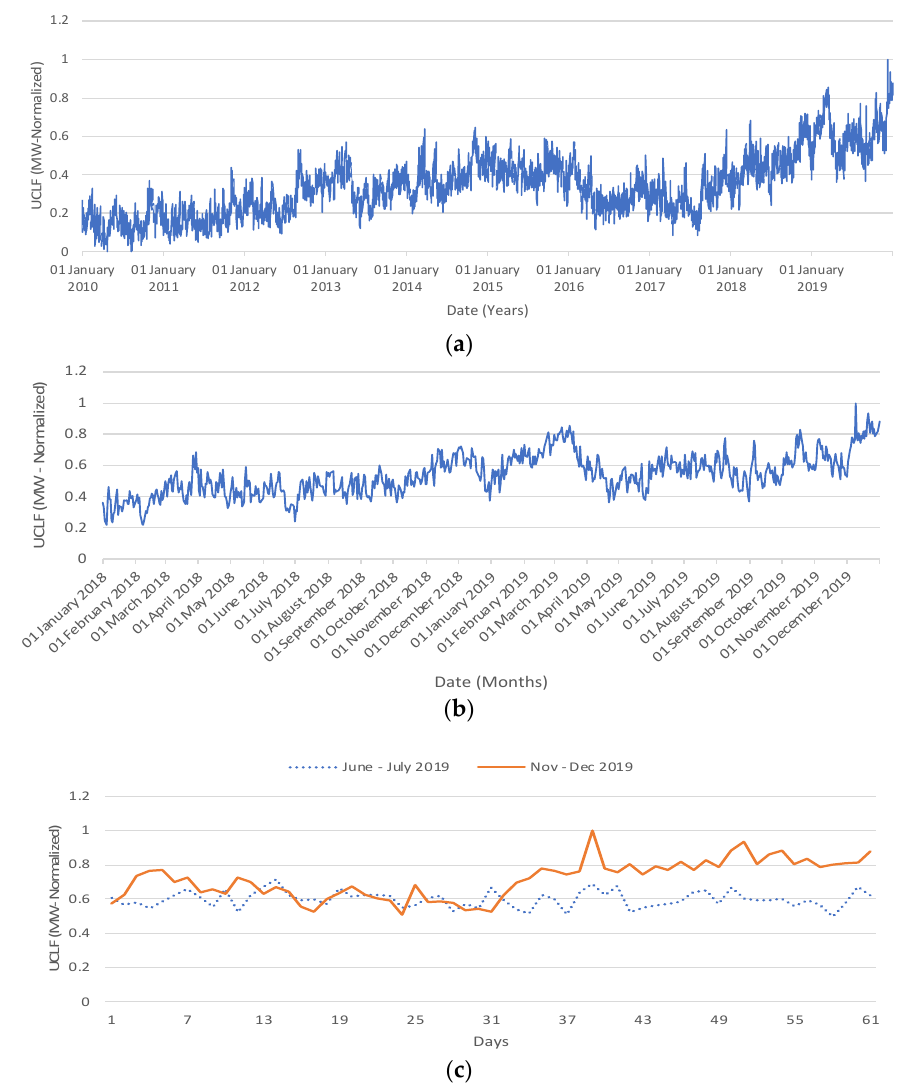
Figure 5. The South African UCLF (MW—normalized): ( a ) UCLF for a period between January 2010